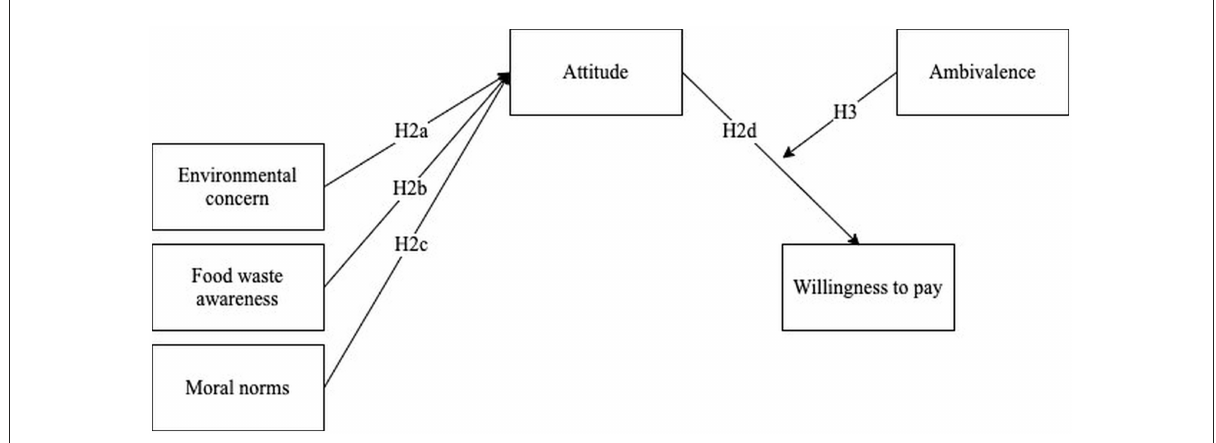
FIGURE1 Conceptual model of consumers’ WTP for suboptimal